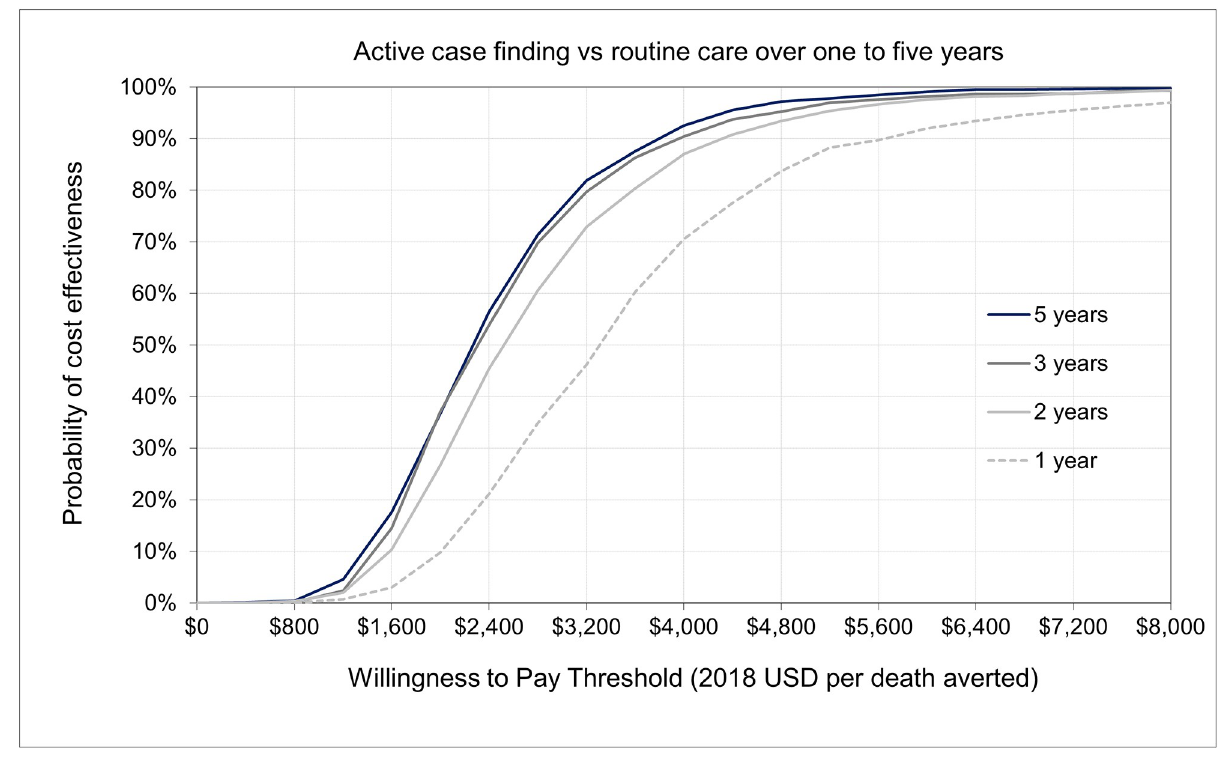
Fig 4. Cost effectiveness acceptability curve of an active tuberculosis case finding intervention compared to routine care, over one to five years (2018–2022) in Zambia. In this figure, the horizontal axis denotes the willingness to pay (WTP) per death averted (incremental cost-effectiveness ratio, ICER), and the vertical axis indicates the probability of ACF being cost-effective based on the proportion of simulations in which the comparison of the ACF intervention to the routine program falls below the WTP threshold. Costs are expressed in 2018 US dollars. At a WTP threshold of $4,800 per TB death averted (about three times Zambia’s GDP per capita in 2018), 97% of simulations suggest that the ACF intervention will be cost-effective compared to the routine program in Zambia over 5 years. This percentage declines to 95% over a three-year horizon, 93% over two years, and 83% in the first year of